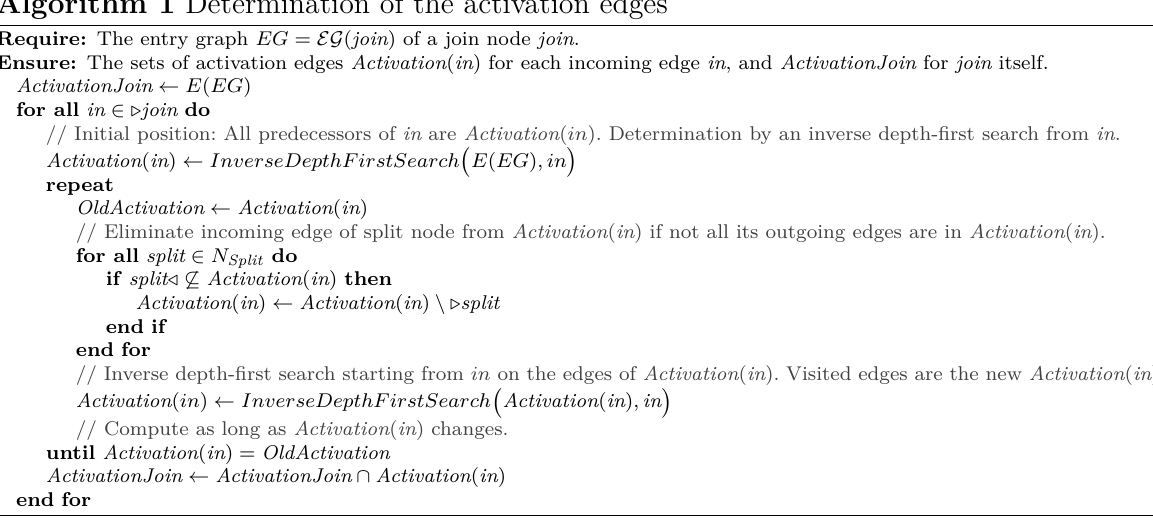
Algorithm 1 Determination of the activation